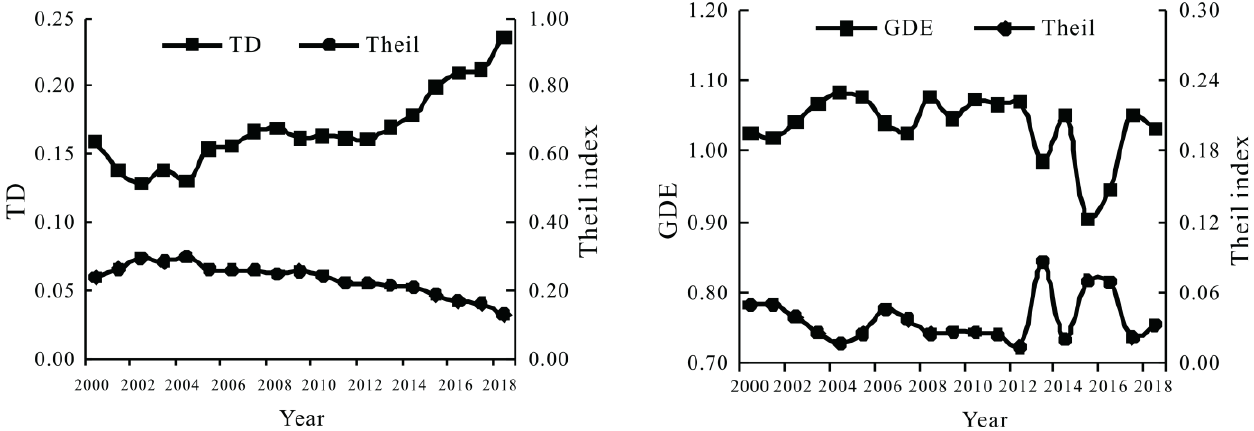
Figure 2. The evolution trend of TD and GDE in the Yangtze River Delta region from 2000 to 2018.